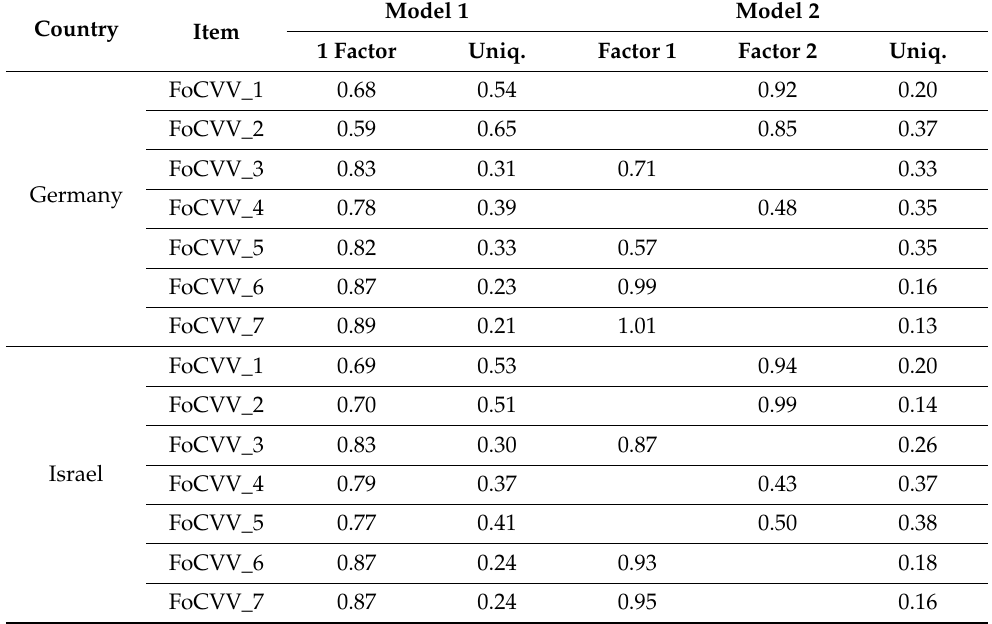
Table 1. Factor loadings for Model 1 (one-factor solution) and Model 2 (two-factor solution) of the Fear of Coronavirus Vaccination Scale for samples from Germany, Israel, Poland, and Slovenia.